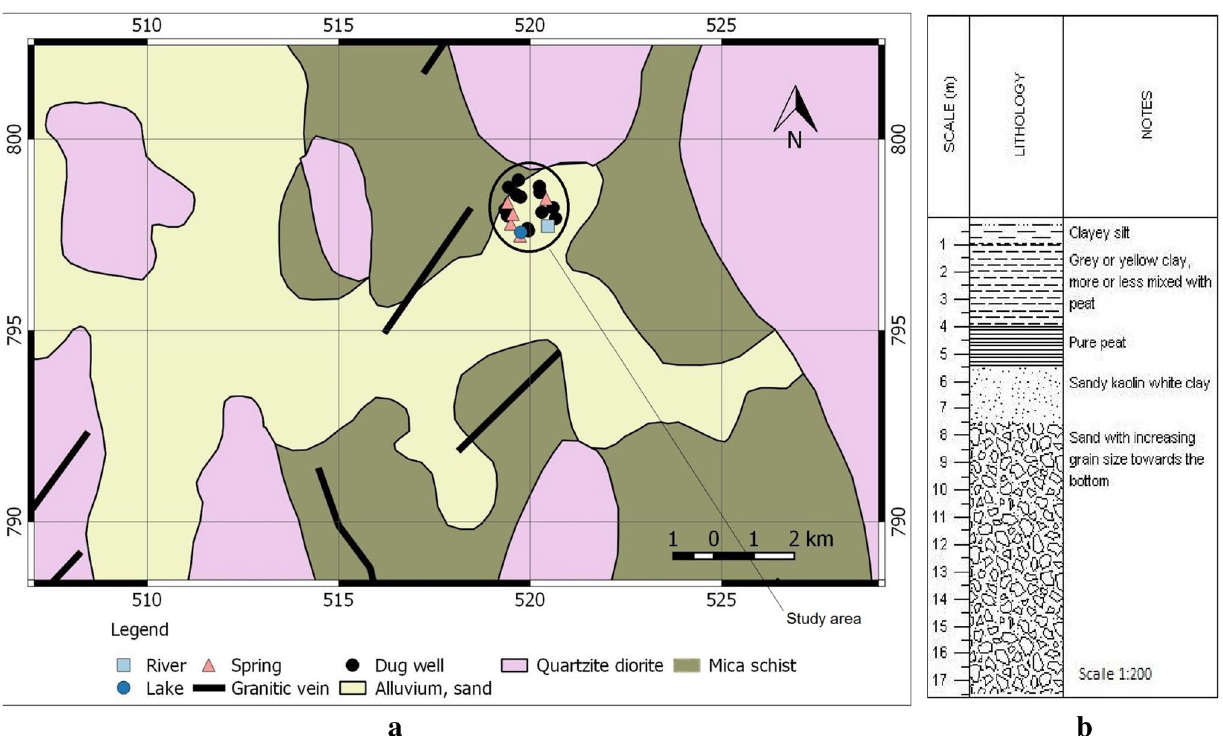
Fig. 2 a Extract of the geological map of Antananarivo Source GEOL500 database. b Stratigraphic log of the alluvial plain (Rakoto et al.